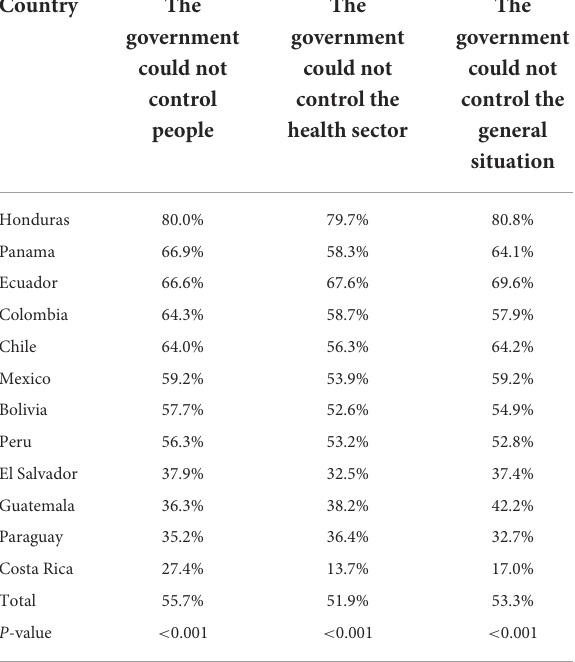
TABLE 2 Inadequate control mechanisms that 12 Latin American governments had in three aspects during the first wave of the COVID-19